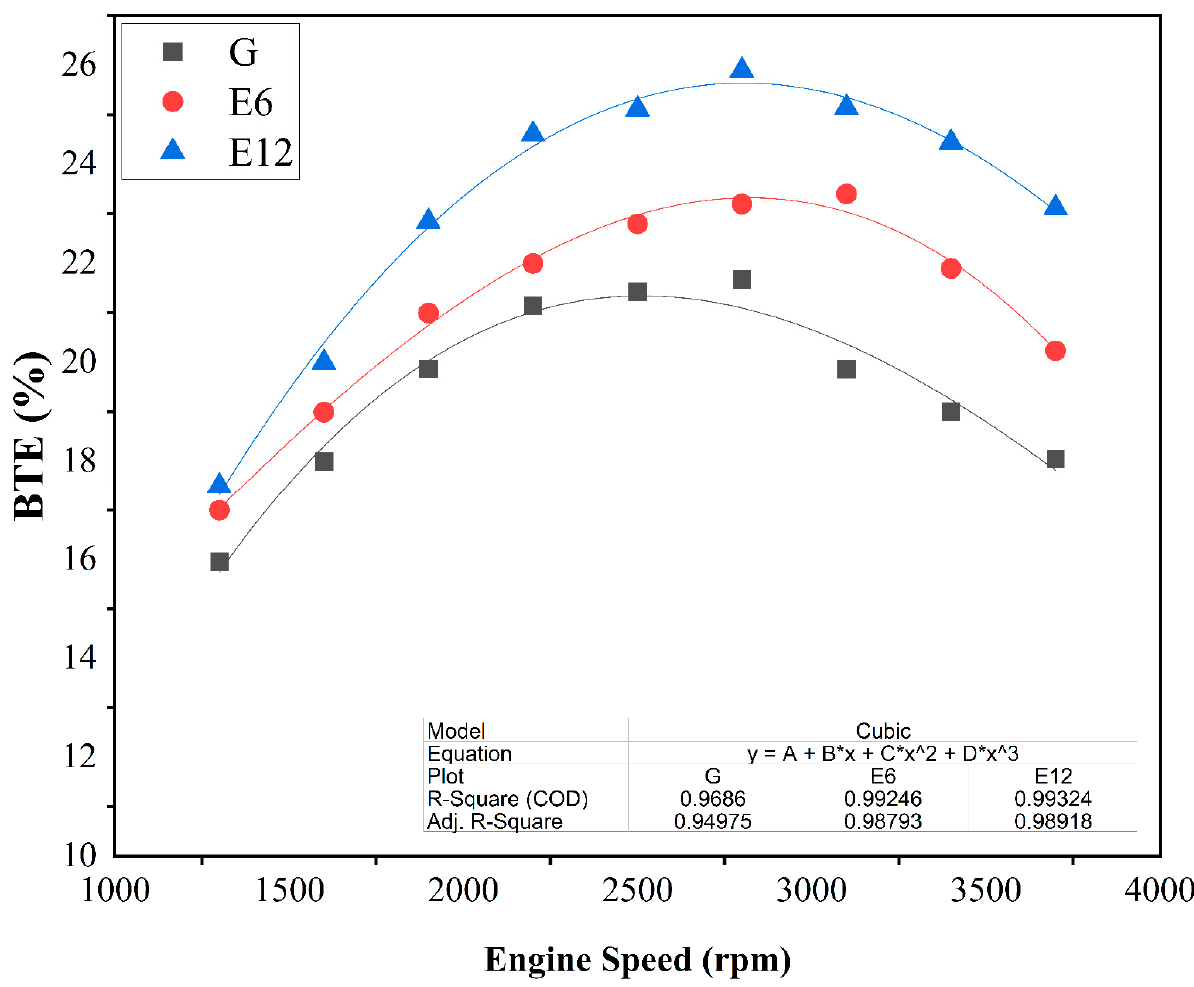
Figure 5. BTE variation with engine speed.